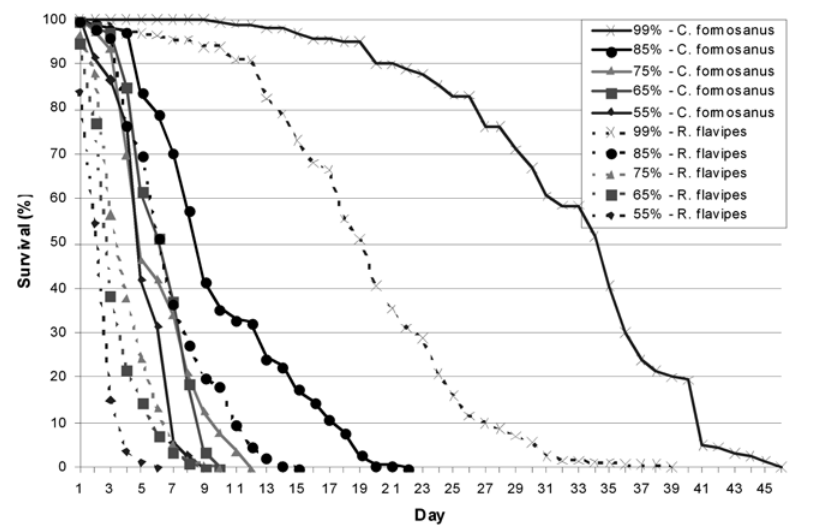
Fig. 2. Survival of small groups (18 workers + 2 soldiers) of C. formosanus and R. flavipes at 15 ° C and varying relative